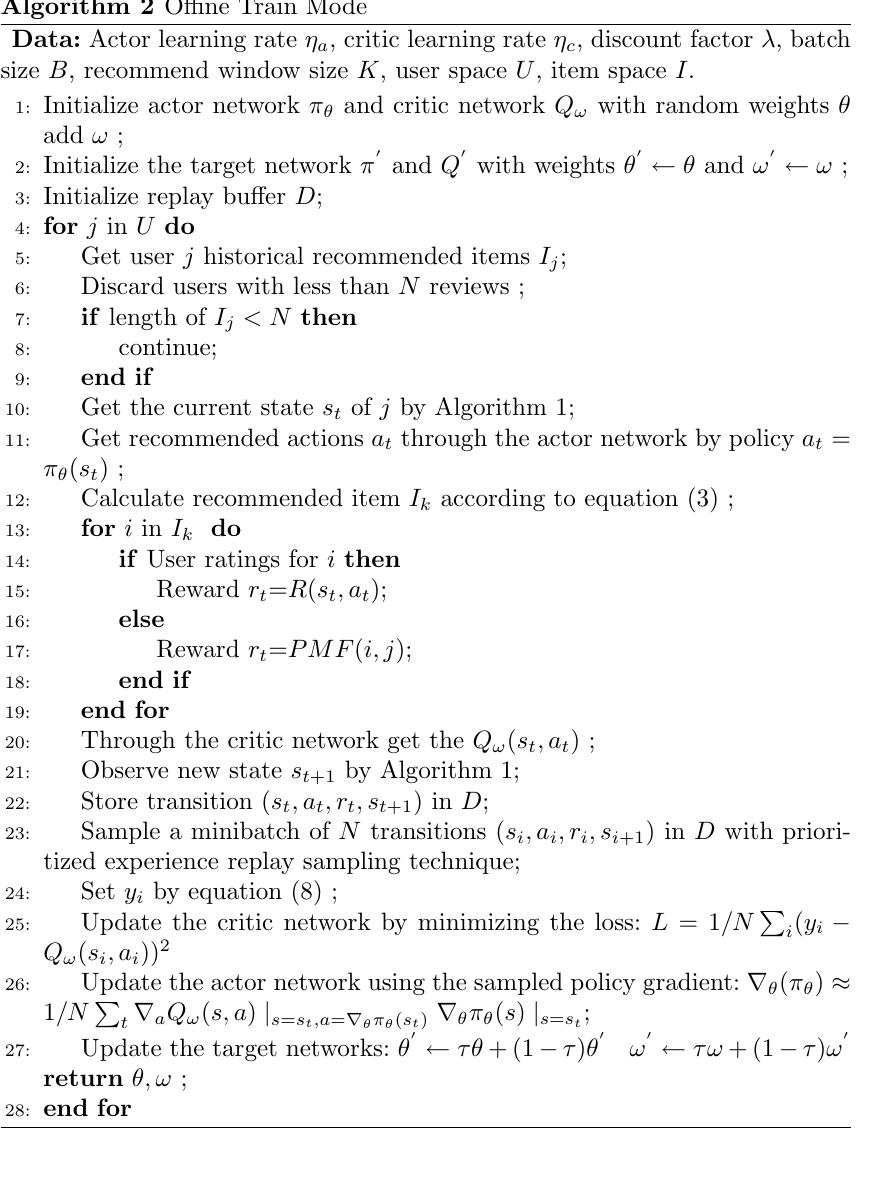
Algorithm 1 is the pseudocode of the state generation